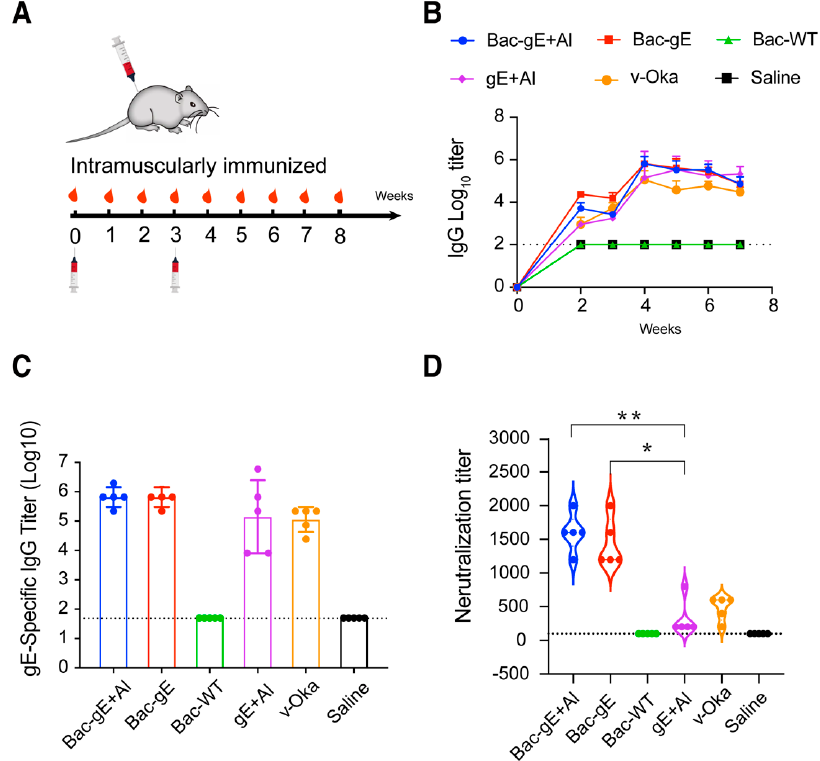
Figure 4. Humoral immune response elicited by Bac–gE in mice. ( A ) Immunization procedure of different VZV vaccine modalities in Balb/c mice. ( B ) gE-specific IgG antibody titers taken each week were determined by indirect ELISA. ( C ) gE-specific IgG antibody titers at week 4 after two rounds of immunization (date was shown as mean ± SD, n = 5). ( D ) Neutralizing antibody titers determined by plaque reduction neutralization assay after boost immunization and plotted as the Violin plot (show all point). One-way ANOVA with Kruskal–Wallis test was used for inter-group statistical comparison. * p < 0.1, ** p < 0.01. Two technical replicates were performed during one experiment.